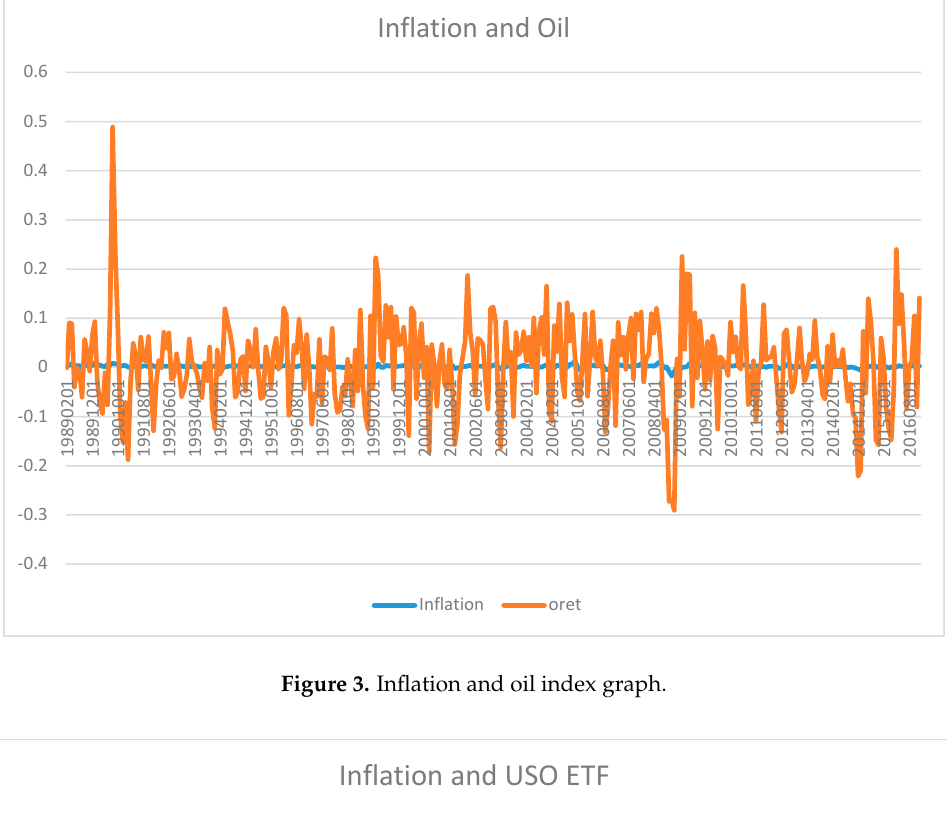
Figure 2. ETF returns graph.